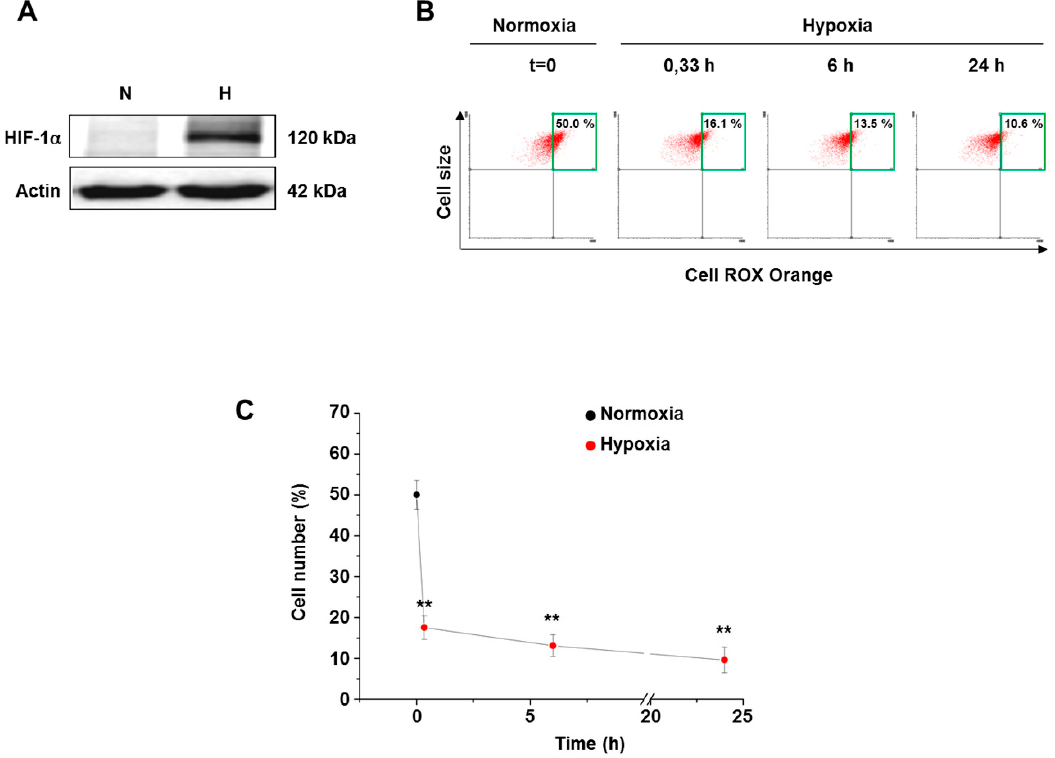
Figure 2. ROS level in human fibroblasts grown under hypoxia. ( A ) HIF-1 α level determined upon 6 h exposure of fibroblasts to either normoxia or hypoxia. ( B ) Representative top right quadrant analysis of CellROX-loaded cells maintained in either normoxia or hypoxia (0.5% O 2 ) up to 24 h. ( C ) Scatter graph showing the time-dependence of cellular ROS level decrease during 24 h hypoxic exposure. Data are means ± SD of three independent experiments, each carried out on four different cell lines. ** p ≤ 0.01 indicates the statistical significance of data compared to normoxia.